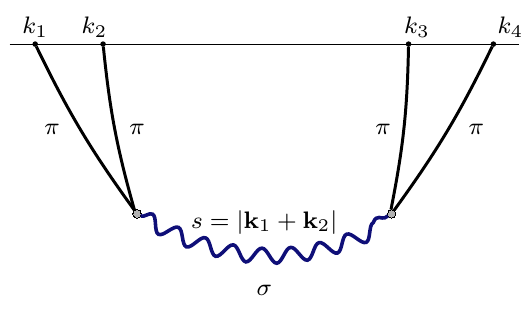
Figure 4 . s -channel exchange diagram for the exchange of a massive spinning